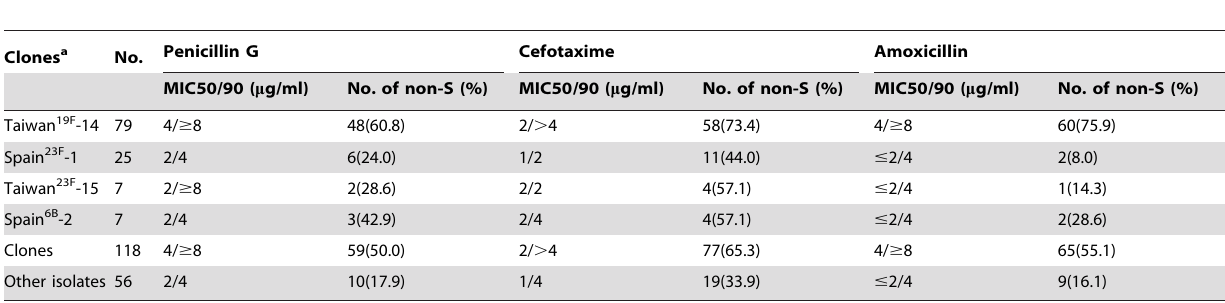
Table 3. The antimicrobial susceptibility and MIC s of b -lactams antibiotics between international antibiotic-resistant clones and other strains.